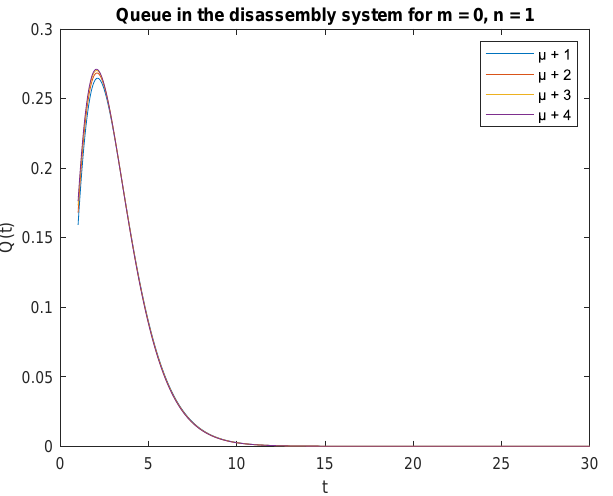
Figure 17. Impact of disassembly rate on probability P { X ( t ) = m = 0 | X ( 0 ) = n = 1 } for λ = 1.